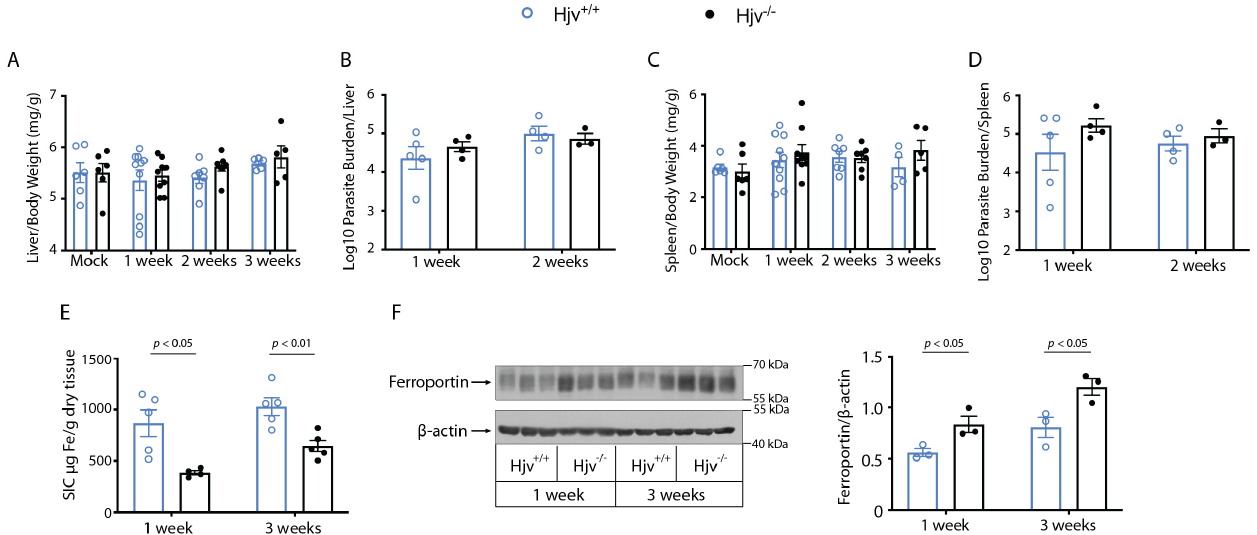
Figure 6. Severe genetic iron overload does not affect visceral leishmaniasis disease progression. Hjv +/+ and Hjv − / − mice were injected intraperitoneally with phosphate-buffered saline or 10 8 L. infantum parasite. Mice were sacrificed 1, 2, or 3 weeks post-infection: ( A ) liver/body weight; ( B ) parasite burden in the liver; ( C ) spleen/body weight; ( D ) parasite burden in the spleen; ( E ) splenic iron content (SIC); ( F ) a representative Western blot of splenic ferroportin; data from n = 3 experiments were quantified by densitometry and are shown on the right. Data are presented as mean ± SEM.